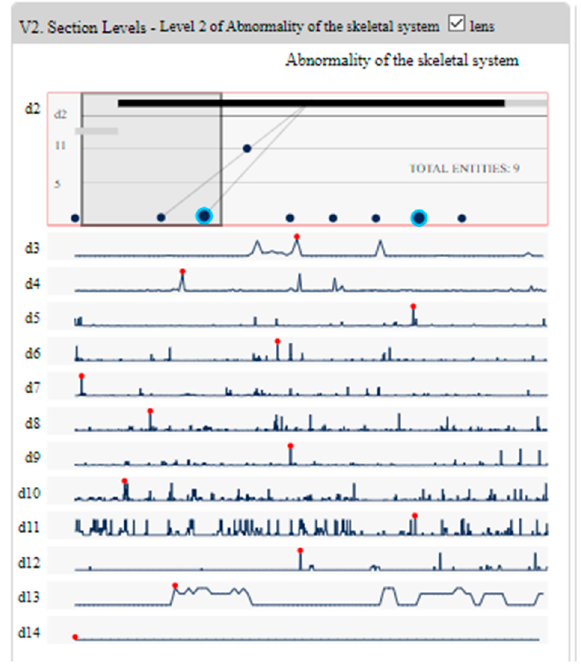
Multimodal Technol. Interact. 2021 , 5 , x FOR PEER REVIEW Figure 13. The initial list of levels within the Ontology Section Levels Panel.